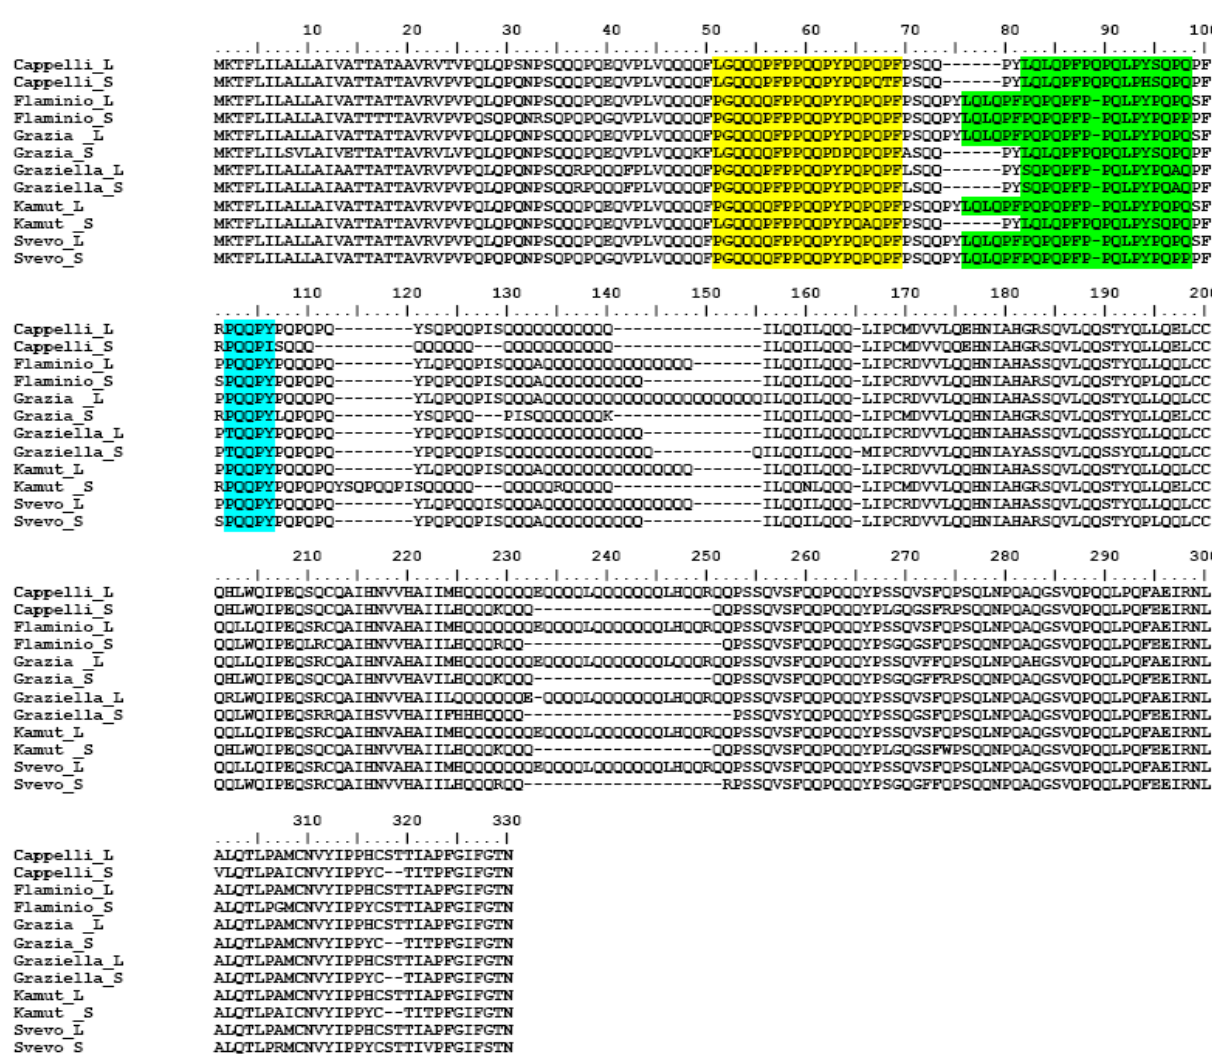
Figure 5. Alignment of deduced L and S α -gliadin isoforms of each wheat accession. Epitopes recognized by PN3 (yellow highlighted) and CDC-5 (green highlighted) mAbs are shown. An additional PQQPY motif (blue highlighted) is